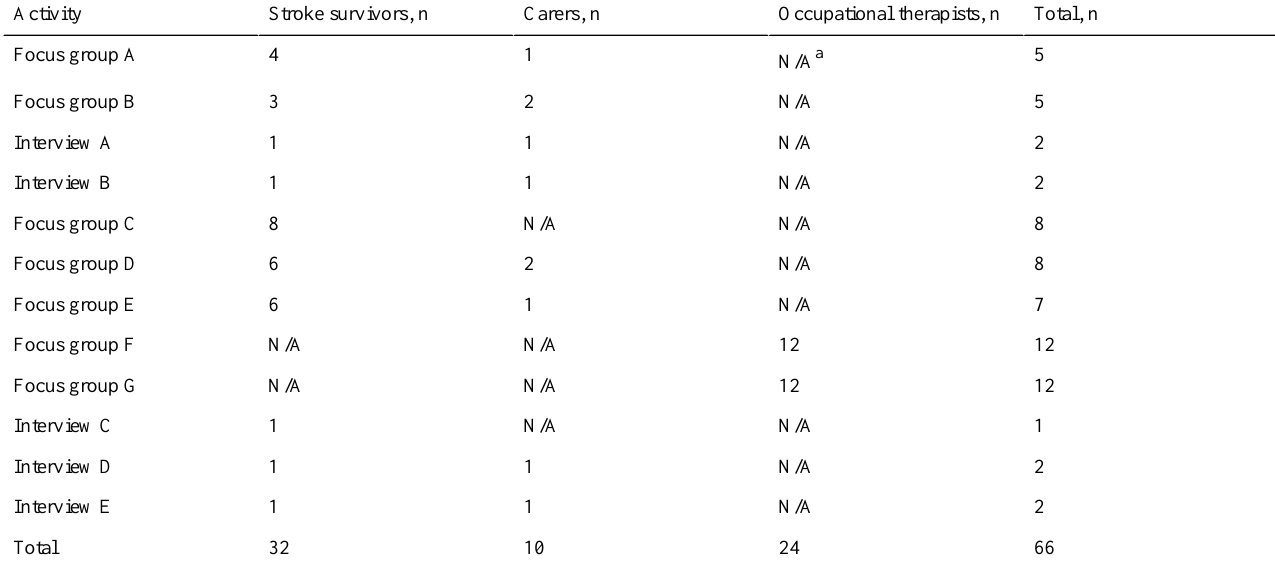
Table 1. Characteristics of stakeholder engagement